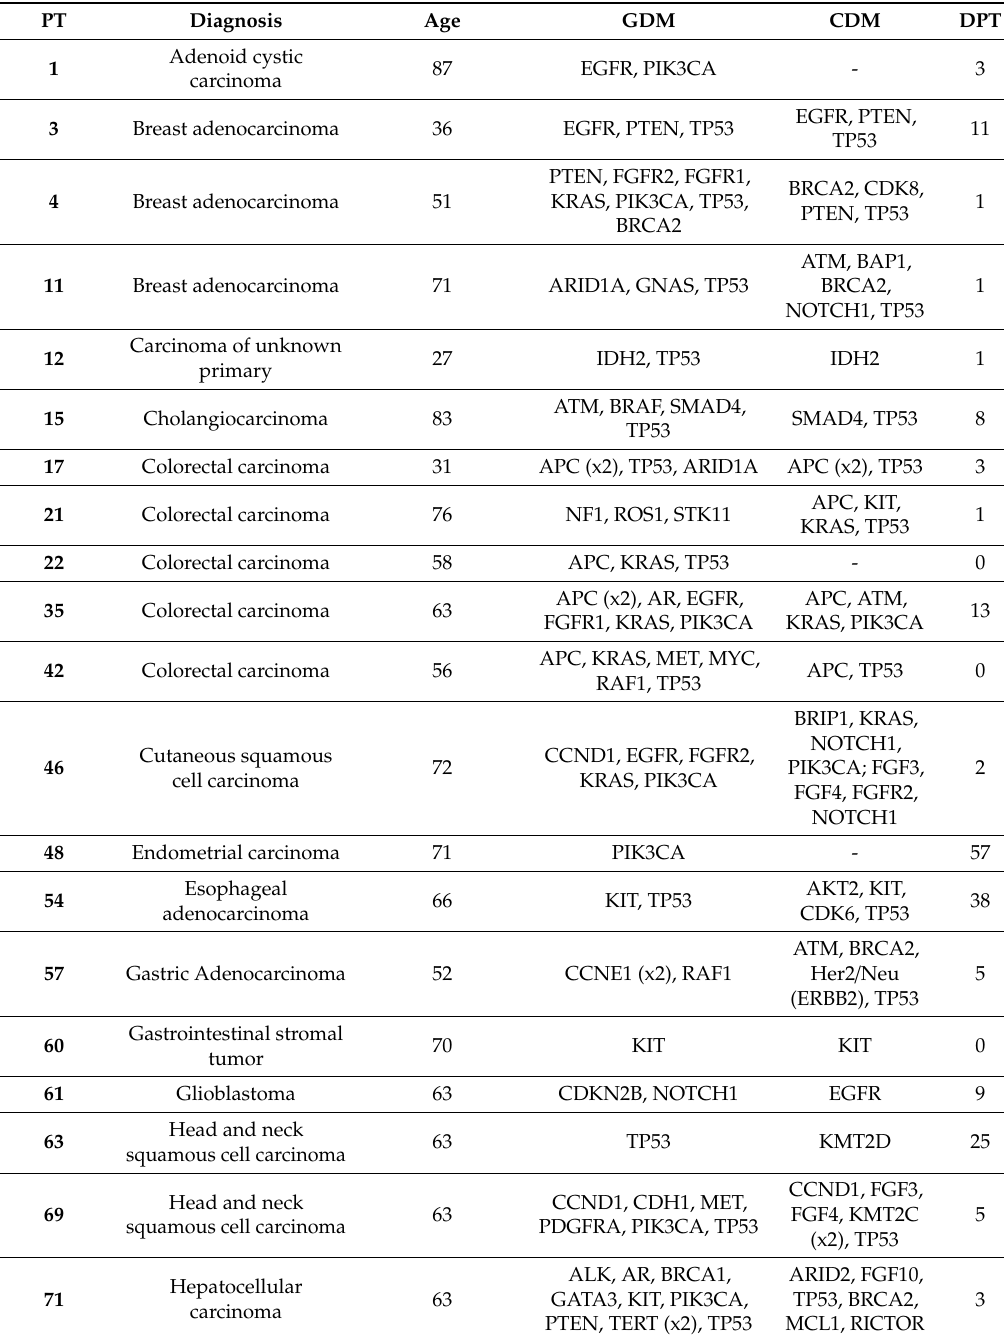
Table 3. Representative data sample of 43 (of 145) patients with accompanying patient numbers and ages. This table displays patients proportional to cancers of both common and rare subtypes. Genetic mutations detected via plasma cfDNA and tissue-based DNA NGS are displayed. Dashes indicate an absence of mutations detected. Time di ff erence indicates gap between sample collections of both platforms in months (DPT). See appendix for